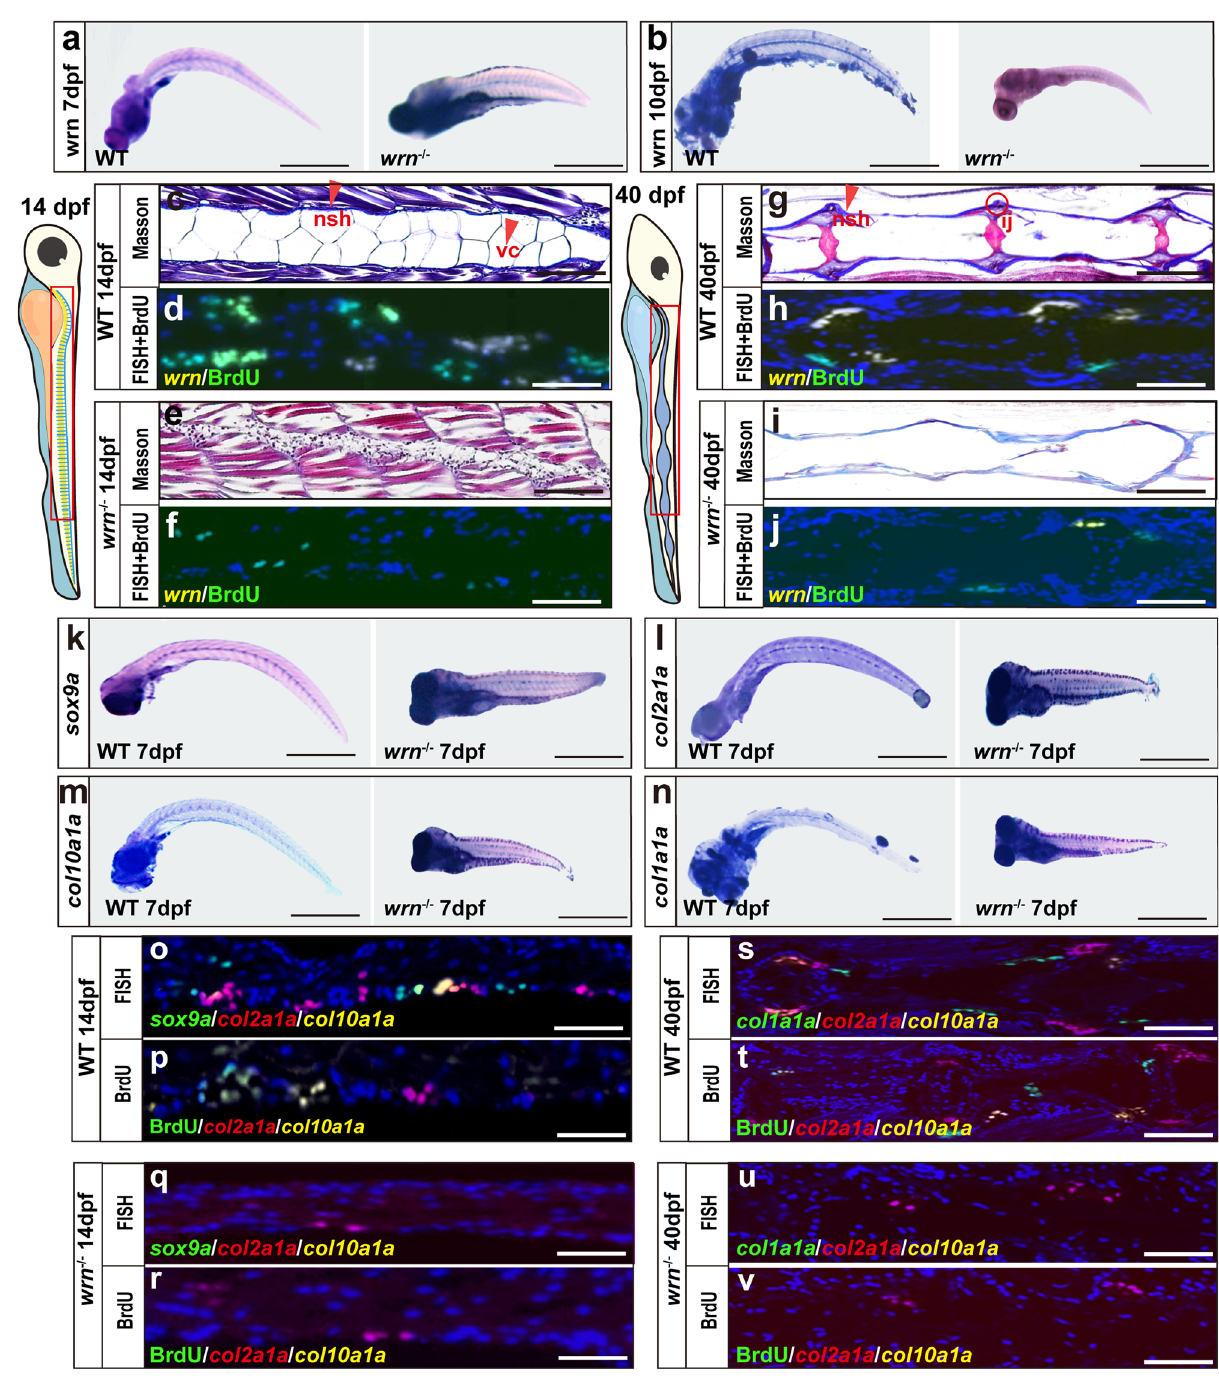
Fig. 2 | Loss of wrn causes bone abnormalities in zebra fi sh. a , b Representative WISH analysis of 3 independent experiments of wrn expression between WT and wrn − / − mutant zebra fi sh onboth 7dpf and 10dpf. c , e , g , i Representative Masson ’ s trichrome staining of 3 independent experiments between WT and wrn − / − mutant zebra fi sh on 14dpf ( c WT; e wrn − / − mutants) and 40dpf ( g WT; i, wrn − / − mutants). Scale bar=100 µ m. Notochord sheath (nsh, red arrow indicated) and notochord vaculated cells (vc, red arrow indicated). Intercentral joint (ij, red encircled) and centrum(ct). d , h , f , j RepresentativeFISHanalysisof3independentexperimentsof wrn expression and BrdU staining between WT and wrn − / − mutant zebra fi sh on